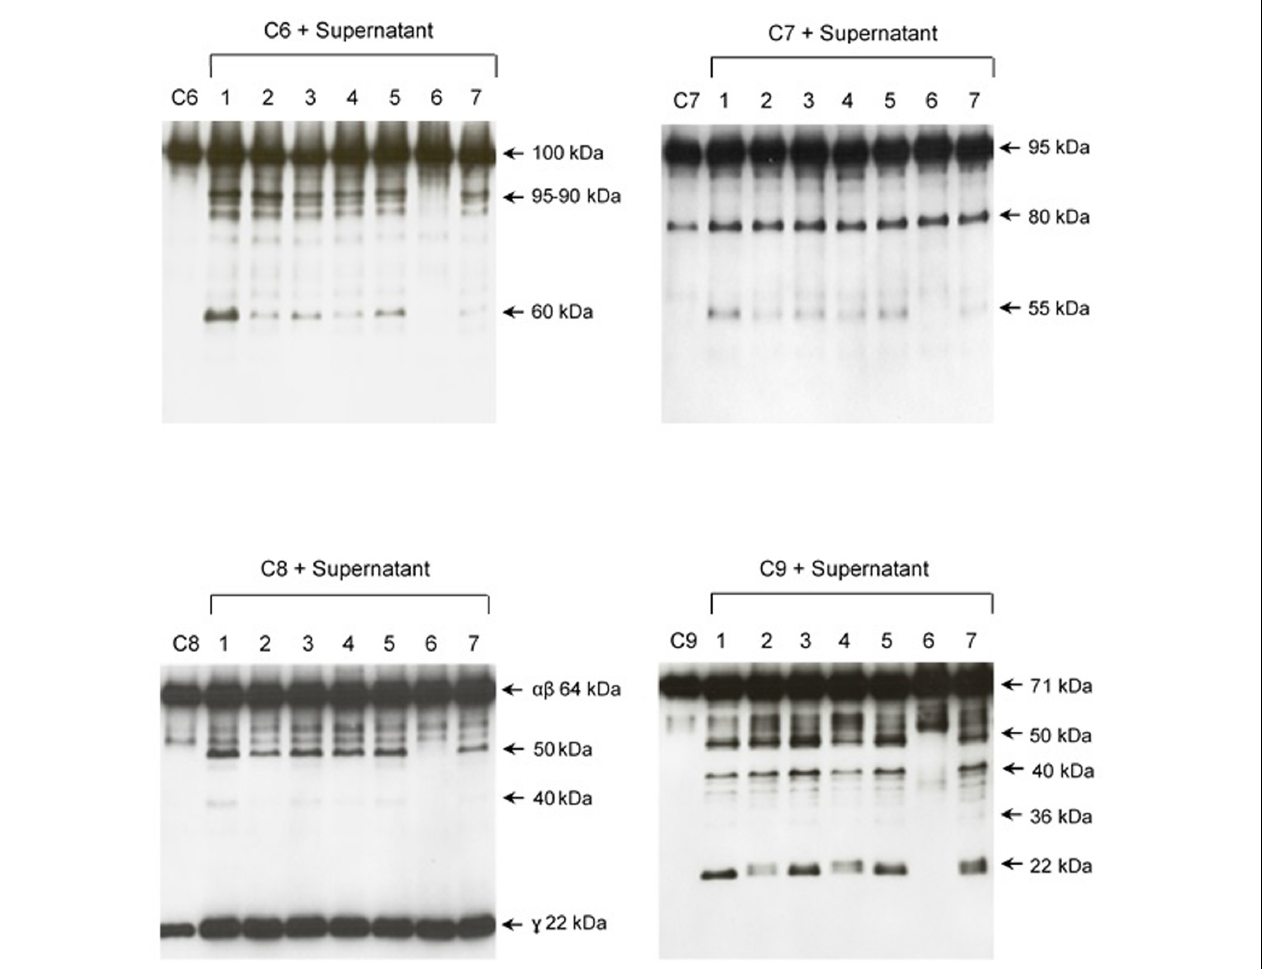
FIGURE 6 | The protease activity of SPL is inhibited by 1.10-phenanthroline. SPL from L. interrogans serovar Kennewiki strain Fromm culture was previously treated with proteases inhibitors of serine-proteases (PMSF; lane 4), cysteine-proteases (E-64; lane 5), metalloproteases (1.10-phenanthroline; lane 6) or aspartyl-proteases (pepstatin; lane 7) before adding Complement proteins. The vehicles of the protease’s inhibitors were used as controls (lane 1) PBS, (lane 2) ethanol: H 2 O (1:1), (lane 3) ethanol. The cleavages of C6, C7, C8, and C9 were analyzed by Western blot with specific polyclonal